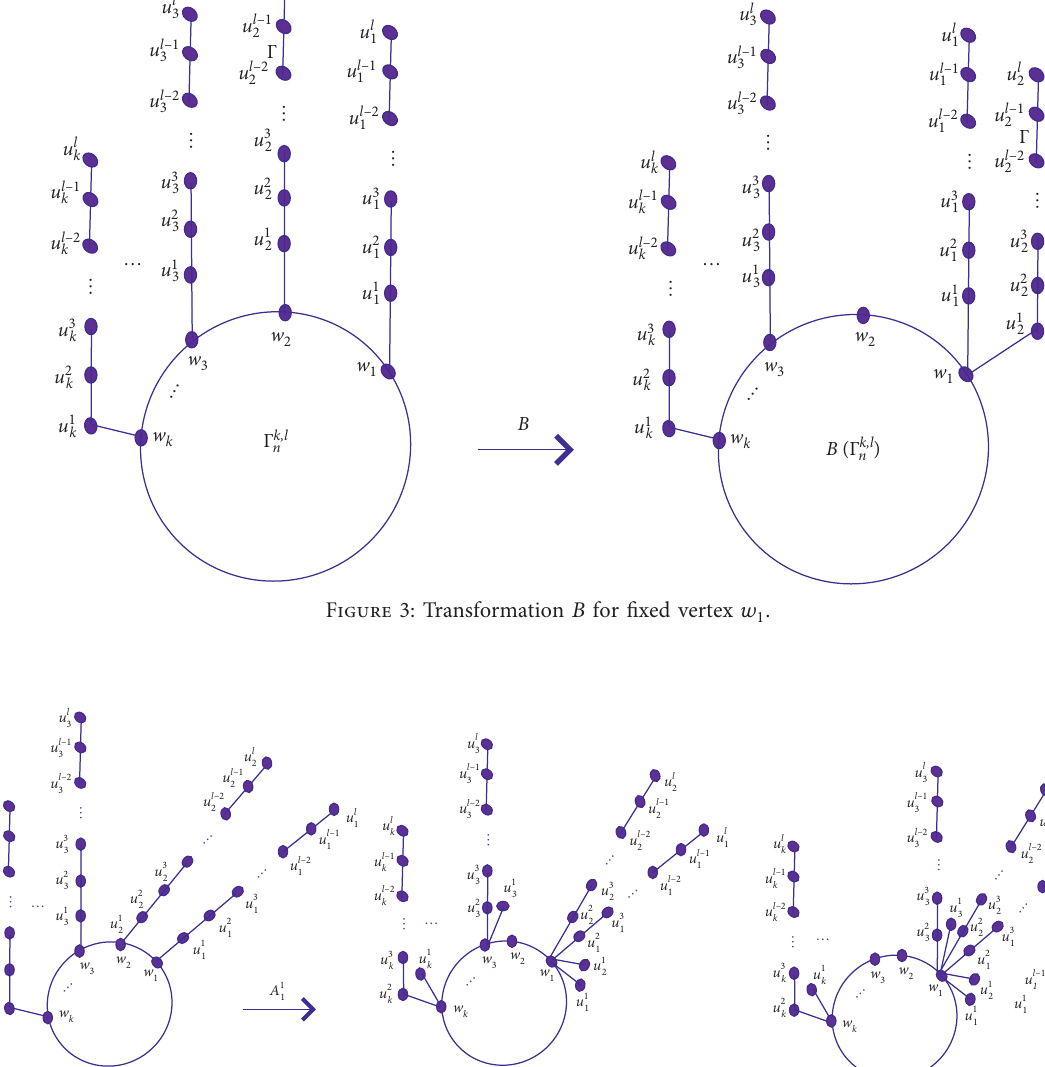
Figure 4: Transformation A β